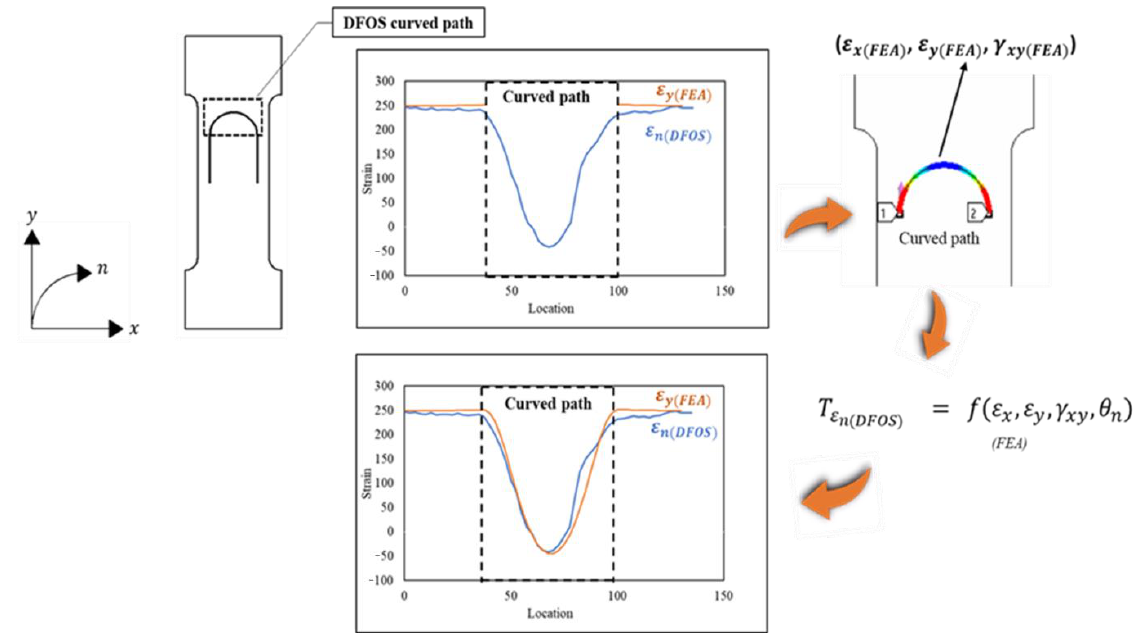
Figure 2. Illustration of the strain transformation method on a semicircular path of the distributed sensor.